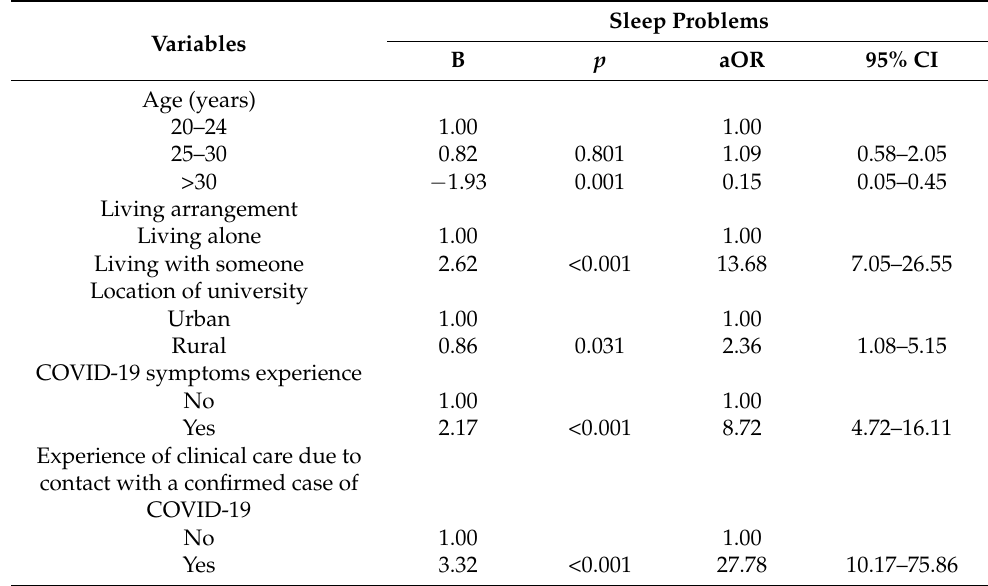
Table 4. Factors associated with sleep problems among international students during the COVID-19 ( N =